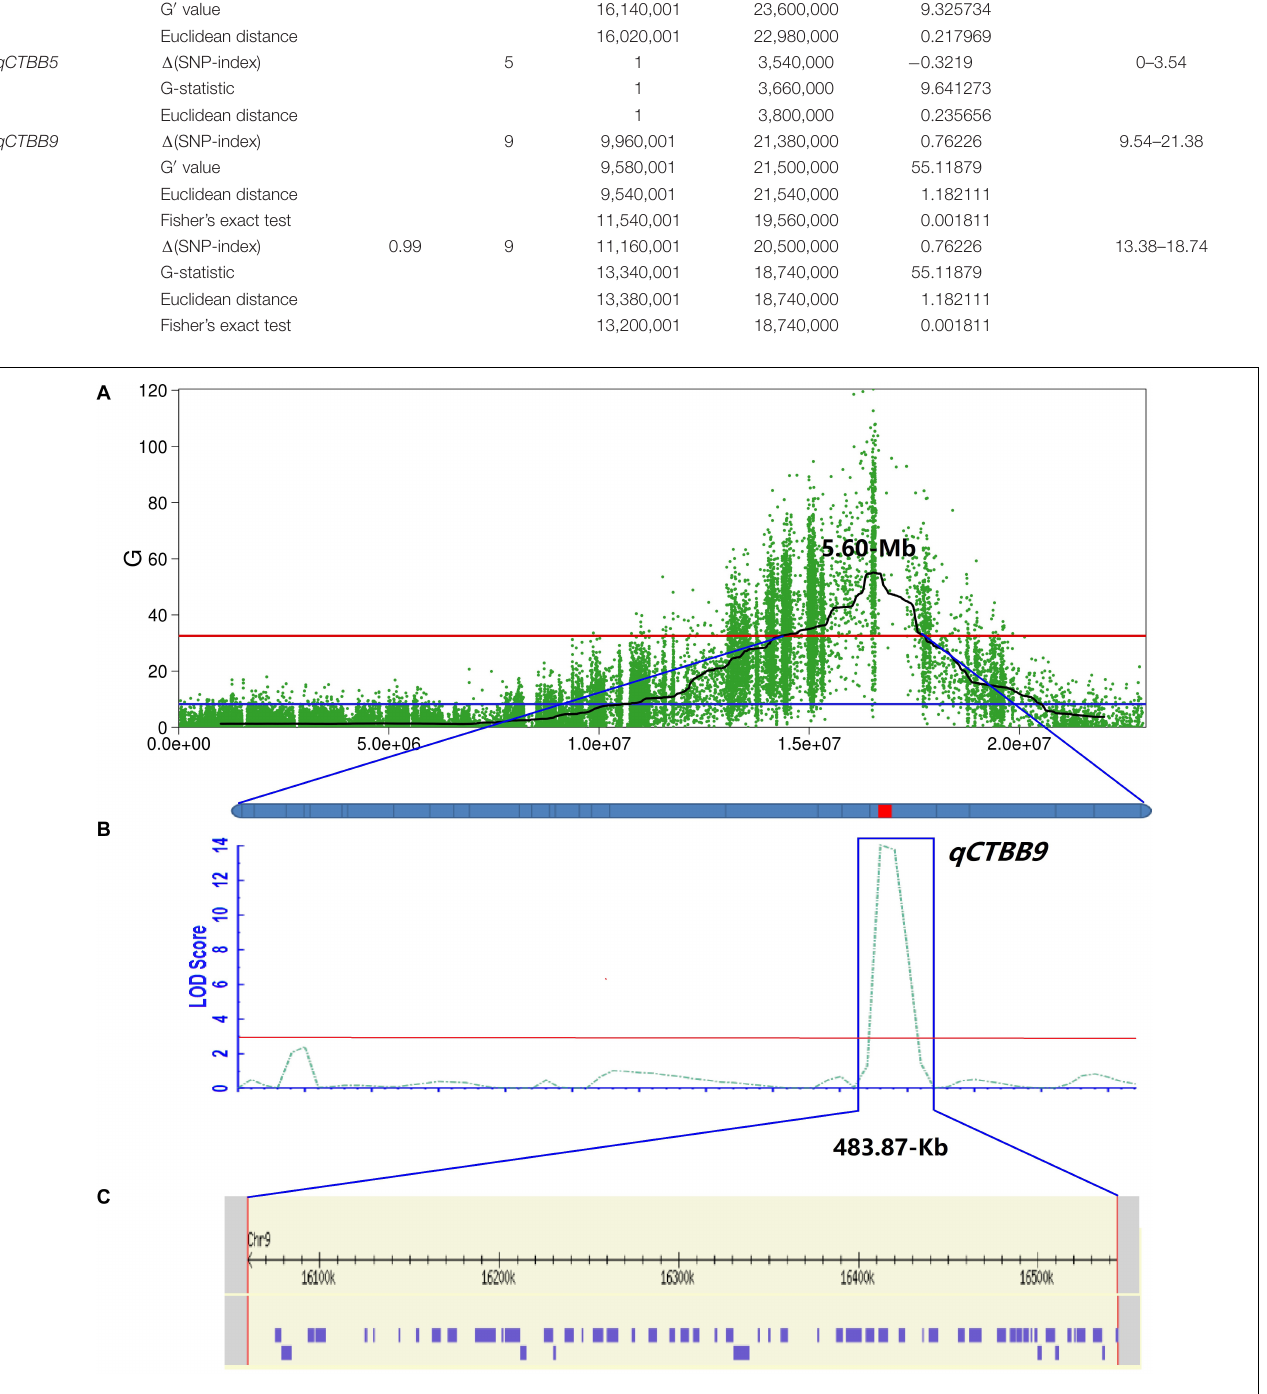
FIGURE 3 | Further mapping of the qCTBB9 . (A) The Manhattan diagram shows the location of the qCTBB9 on chromosome 9. (B) qCTBB9 detected by using the ICIM module of QTL IciMapping 4.2. Linkage map based on KASP markers. The red lines represent the logarithm of odds (LOD) threshold of 2.0. (C) 58 genes in qCTBB9 region were obtained through the annotation information on the Nipponbare genome.